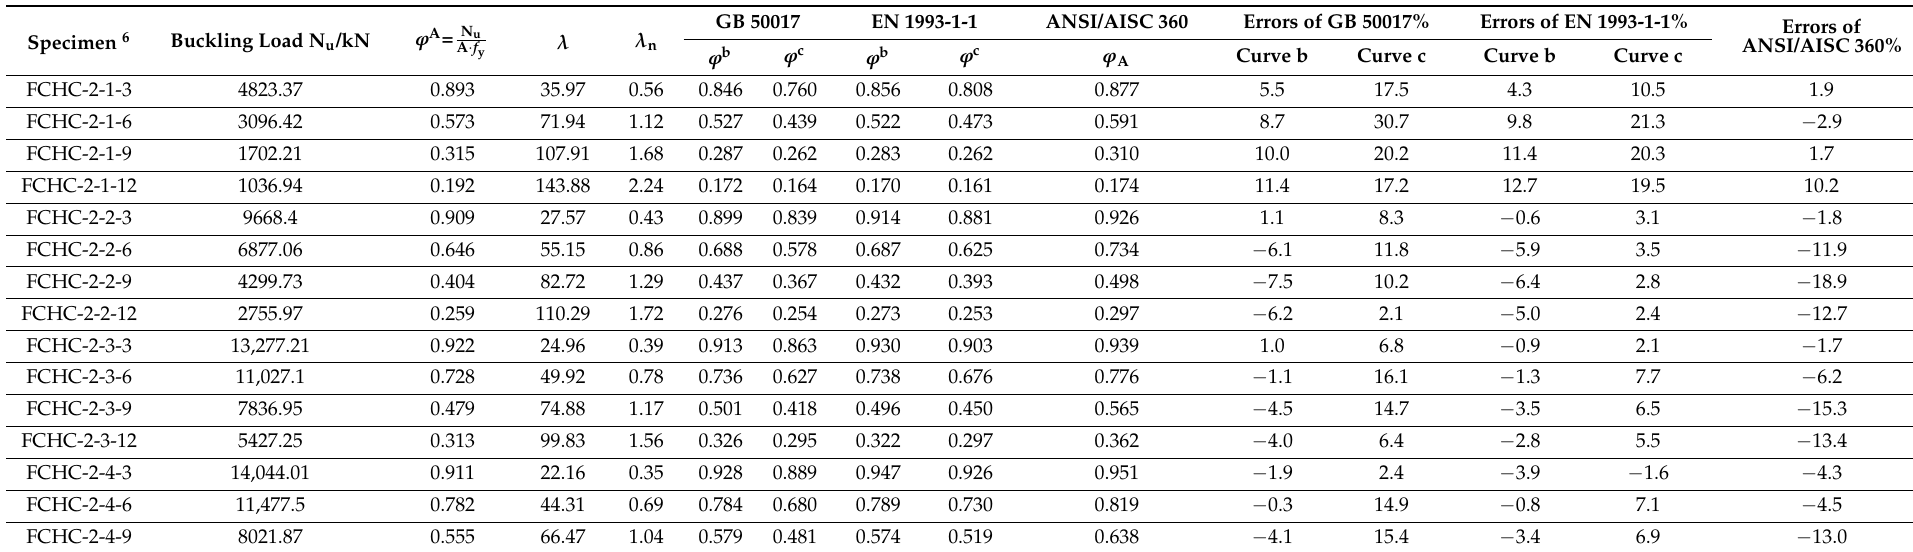
Table 8. Buckling resistance for Q460 specimens with comprehensive imperfections of Curve b in Table